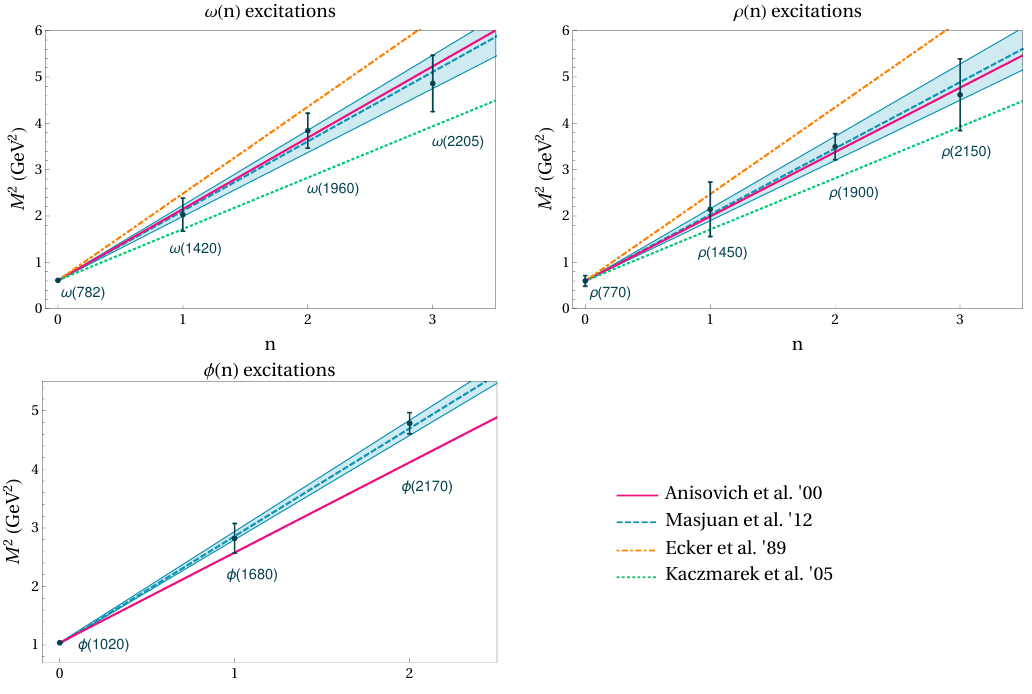
Figure 5. Radial Regge trajectories of the isovector (cid:26) and isoscalar ! and (cid:30) vector mesons. The states ! (782), ! (1420), (cid:26) (770), (cid:26) (1450), (cid:30) (1020), (cid:30) (1680), and (cid:30) (2170) are from PDG [90]. The states ! (1960), ! (2205), (cid:26) (1900), and (cid:26) (2150) are extracted from ref. [108]. The errors are de(cid:12)ned as (cid:1) M 2 = (cid:0) M [108]. The solid magenta lines are from ref. [109] with (cid:27) 2 1 : 39 GeV 2 , and (cid:27) 2 = 1 : 54 GeV 2 . The turquoise bands are from ref. [108] with (cid:27) 2 (cid:30) (cid:27) 2 = 1 : 43(13) GeV 2 , and (cid:27) 2 = 1 : 84(6) GeV 2 . The green dotted lines with slope (cid:27) 2 = 1 : 11 GeV 2 are (cid:26) (cid:30) based on the lattice calculation of ref. [110]. The orange dot-dashed lines with slope (cid:27) 2 = 1 : 87 GeV 2 are based on the (cid:26) ! 2 (cid:25) decay [106,